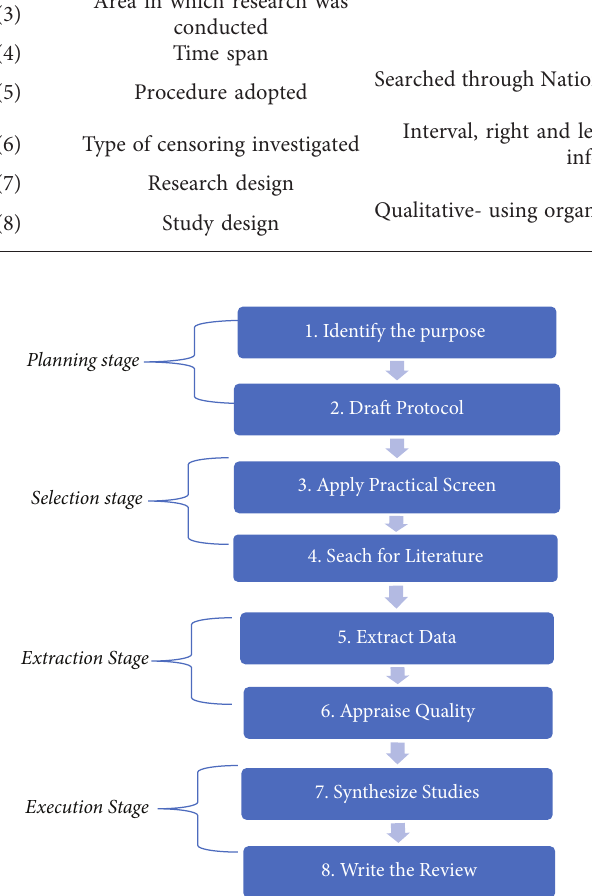
Figure 1: A systematic guide to literature review